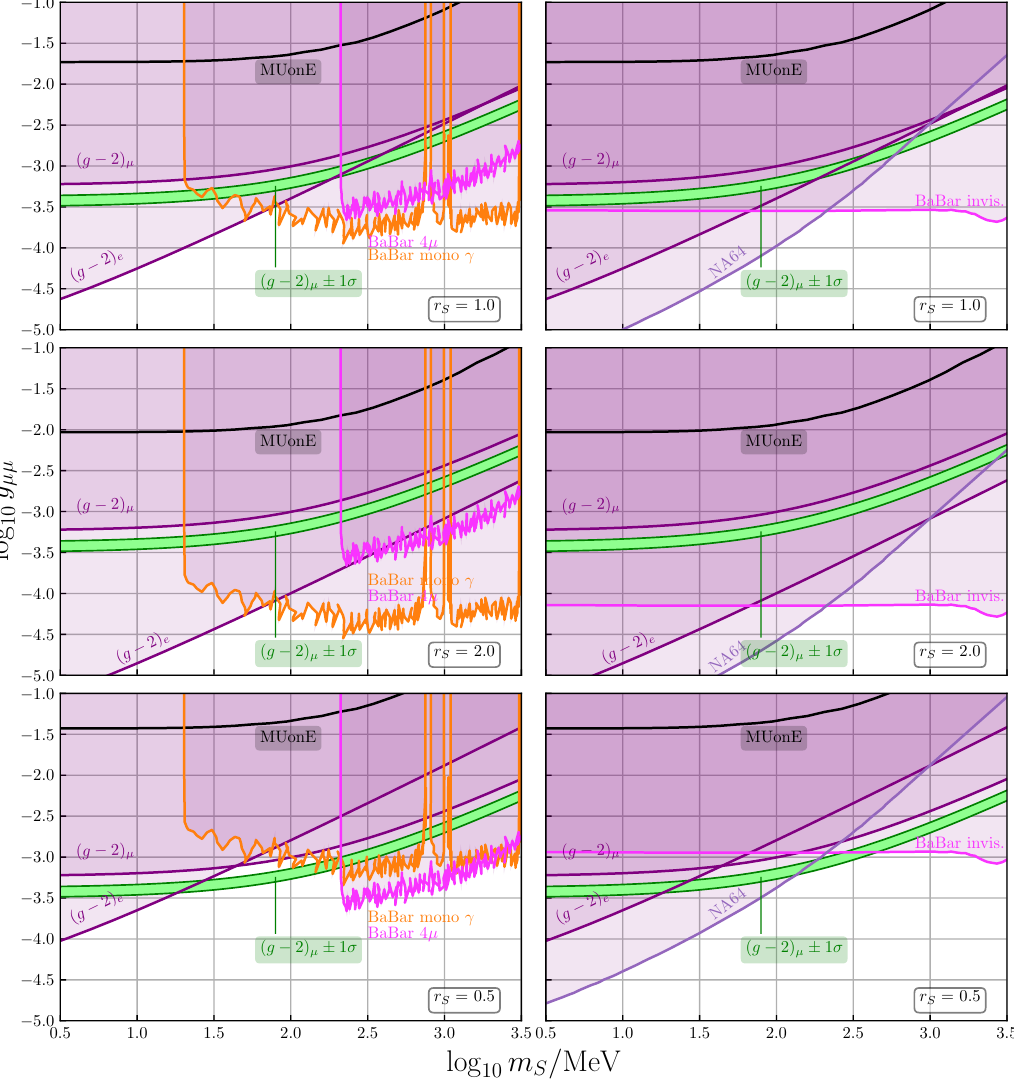
Figure 11 . MUonE sensitivities on m S and y (cid:22)(cid:22) and current constraints on S in the t -channel with the couplings in eq. (2.20) and for r S = 1 (upper panel), 2 (middle panel) and 0.5 (lower panel), with S decaying visibly (left panel) or invisibly (right panel), with the same color coding same as in (cid:12)gure